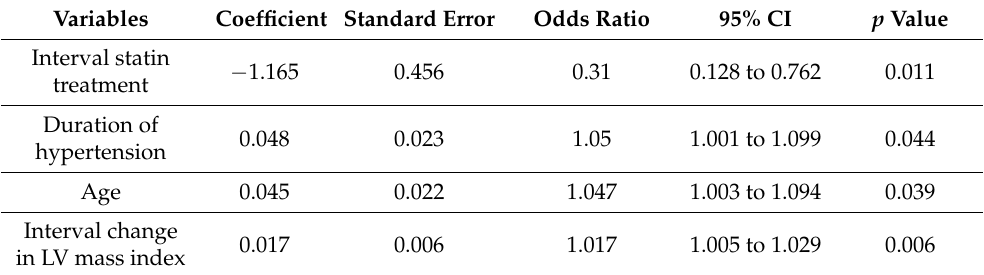
Table 4. Independent predictors of HFpEF in asymptomatic patients with concentric LV hypertrophy.